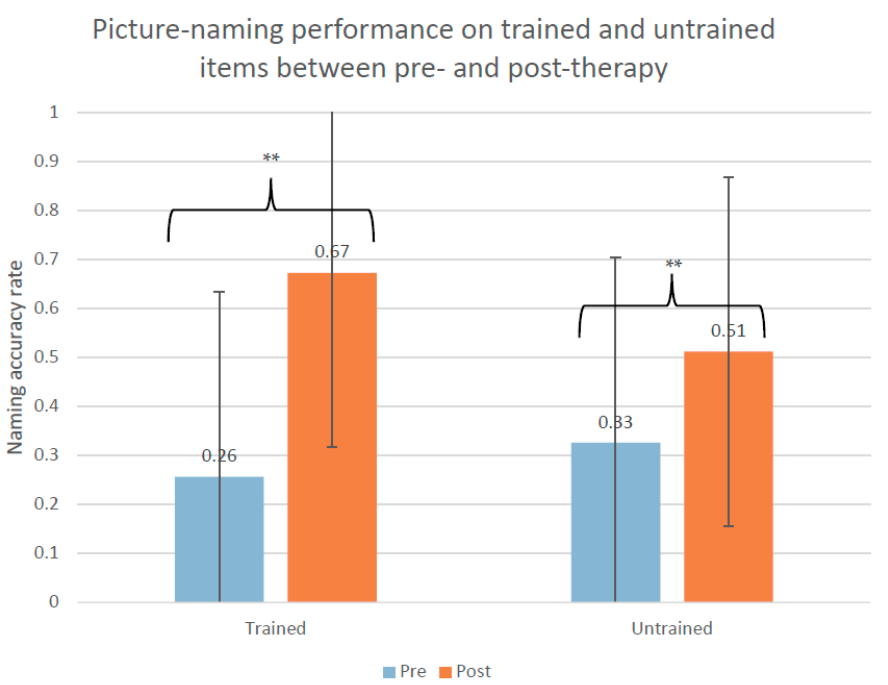
Figure 2. Picture-naming performance on trained and untrained items pre-therapy and post-therapy. ** p = 0.005. Table 2. Functional connectivity changes following Fr-PCA therapy.